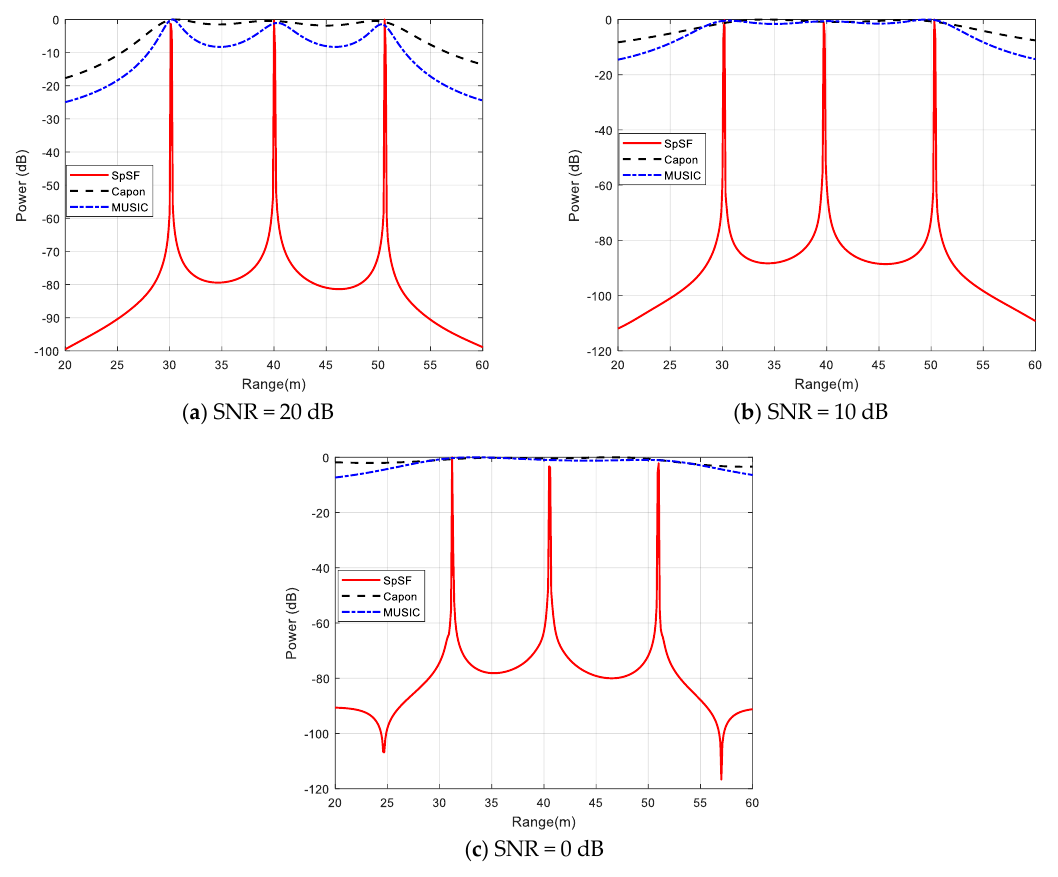
Figure 9. Range estimation of the simulated data.